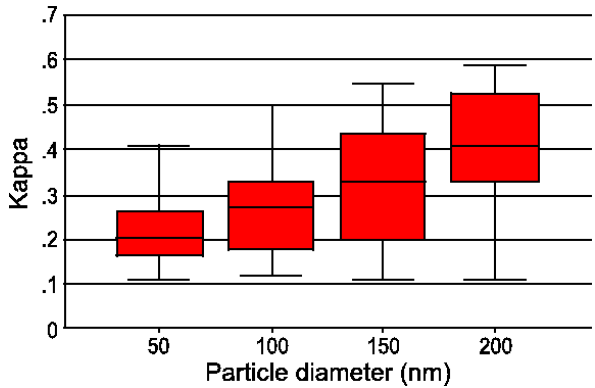
Figure 4. Variability in the hygroscopicity (quantified by  , see text) of aerosols as Fig. 4. Variability in the hygroscopicity (quantified by κ , see text) a function of size observed during CARMA-III in the region of the California of aerosols as a function of size observed during CARMA-III in the cloud deck. Data were from a H-TDMA. The error bars and red boxes denote the region of the California cloud deck. Data were from a H-TDMA. 95% and quartile ranges, respectively, of the measurement population. (Derived The error bars and red boxes denote the 95% and quartile ranges, from Kaku et al, 2006.) respectively, of the measurement population. (Derived from Kaku et al., 2006.)